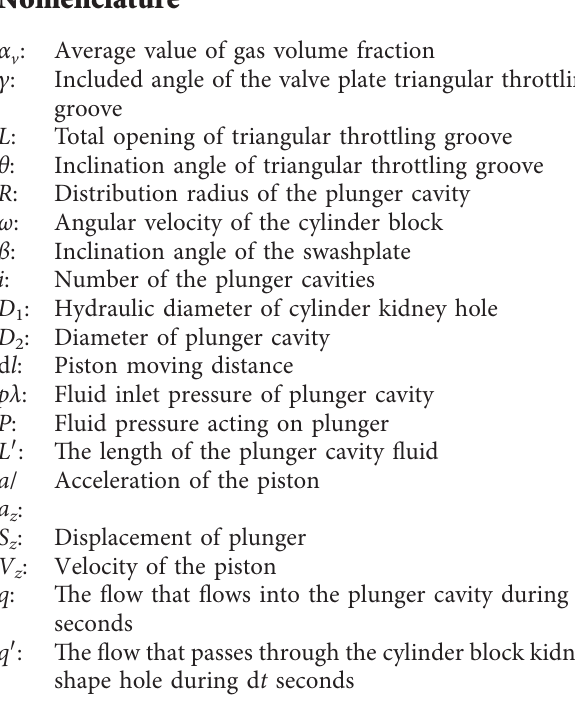
v of plunger cavity at different value of